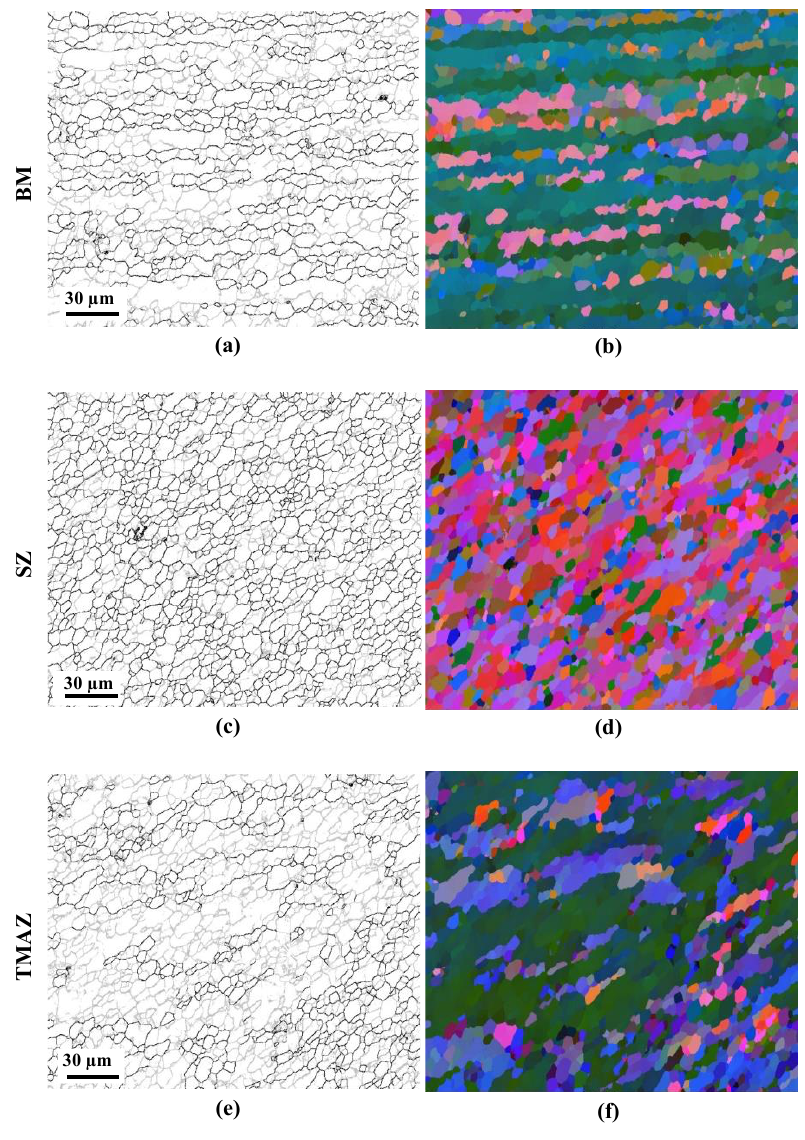
Figure 4. EBSD Grain boundary reconstruction maps and corresponding Euler maps for the FSP AA6082 sample: ( a , b ) BM; ( c , d ) SZ; ( e , f ) TMAZ.